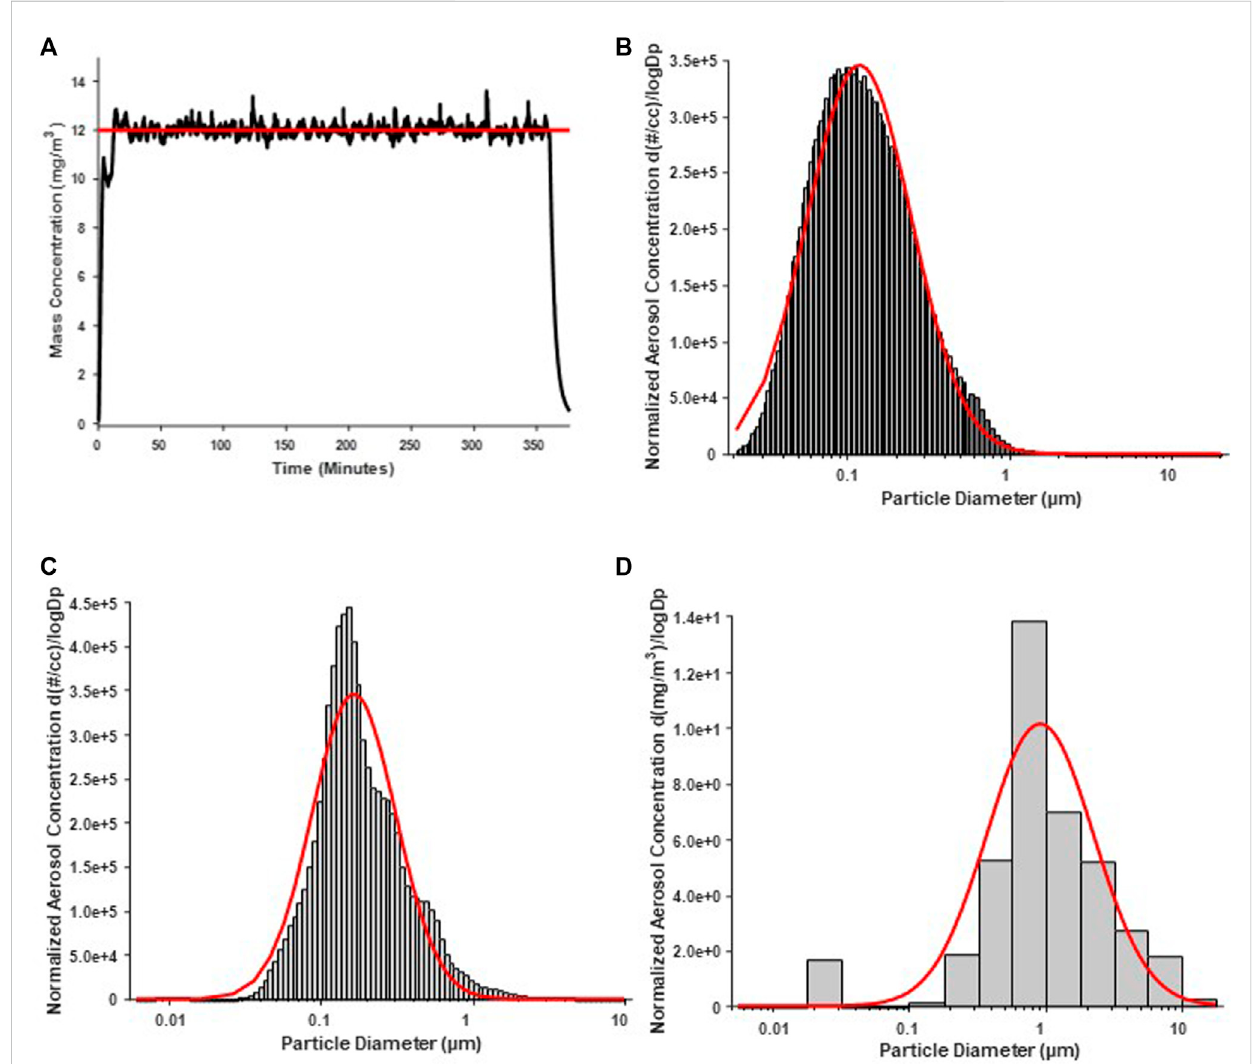
FIGURE 1 Nano-TiO 2 aerosolreal-timecharacterizations.Aerosolcharacterizationwasmonitoredandveri fi edduringtheexposureperiods.Redlinesindicate sizedistributioncurvesforalognormal fi tofthesizedata. (A) Programsoftware-controlledaerosolmassconcentrationoverthe6-hexposureparadigm. Real-time nano-TiO 2 aerosol mass concentration (black line) was maintained near the desired 12 mg/m 3 , the target average concentration (red line). (B) Aerosol aerodynamic diameter wasassessedbyscanningmobilityparticlesizer(SMPS;lightgray)and anaerodynamicparticlesizer(APS;darkgray). Theparticlediameter,determinedbySMPSandAPS,hadaCMDof118 nmandageometricstandarddeviationof2.10. (C) Aerosolaerodynamicdiameter wasalsoassessedbyahigh-resolutionelectrical low-pressureimpactor(ELPI)whichhadaCMDof164 nmandgeometricstandarddeviation of1.89. (D) A nano micro-ori fi ce uniform deposit impactor (MOUDI) was used to evaluate aerosol mass size distribution and indicated a mass median aerodynamic diameter (MMAD) of 0.918 µm and a geometric standard deviation of 2.47.